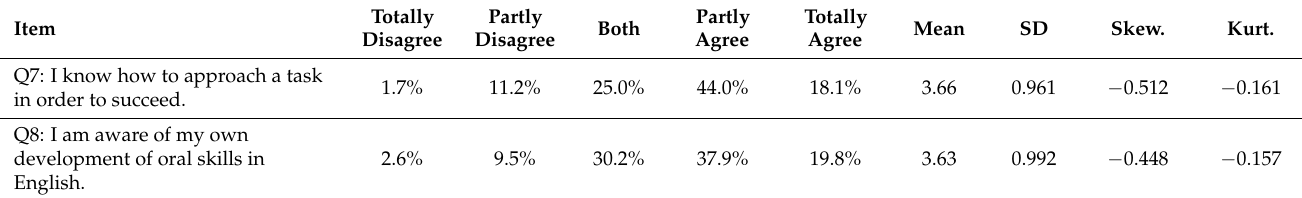
Table 5. Students’ reported language